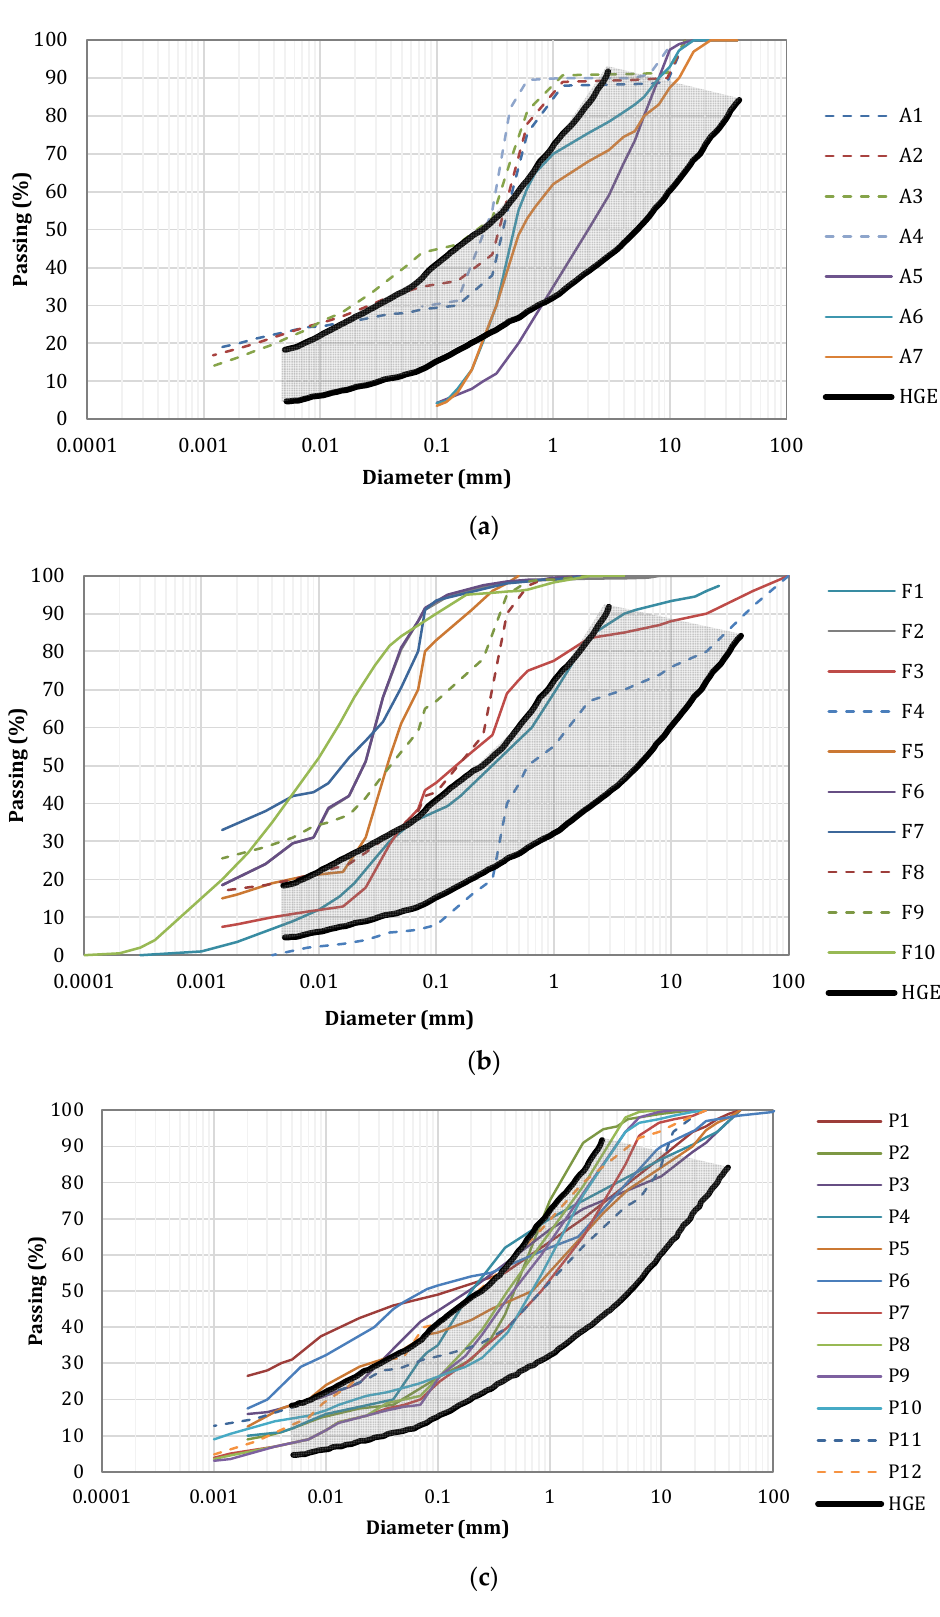
Figure 1. PSD for soils and soil mixtures used in RE structures in: ( a ) Australia: A1—A3 [34], A4 [36]; A5—A7 [37]; ( b ) France: F2 [31], F1 [34], F5—F7 [35], F3 [40], F8—F10 [46], F4 [48]; and ( c ) Portugal: P1—P6 [4], P7—P10 [41], P11 [42], P12